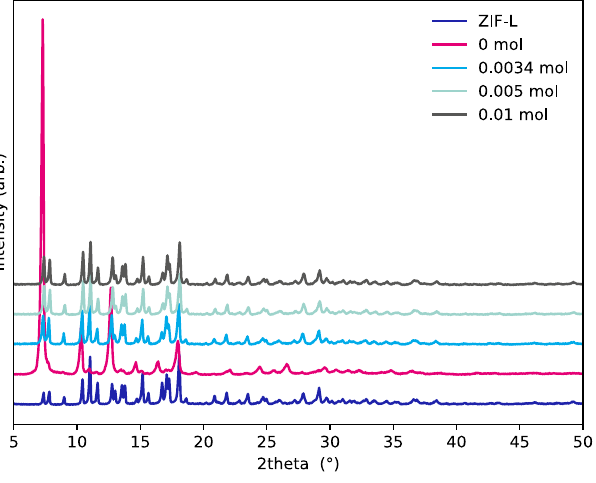
Fig. 6 Diffraction data from samples washed with additional linker. PXRD patterns of samples washed for 24 h with various quantities of 2-methlyimidazole